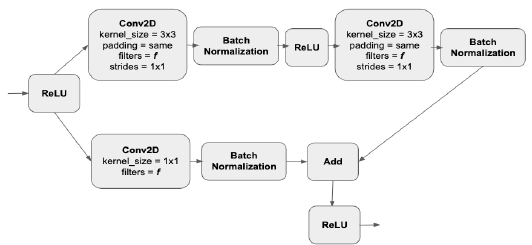
Figure 6. Convolutional Block for the MM-HR model shown in Figure 4. f depends on the number of input filters to the block.